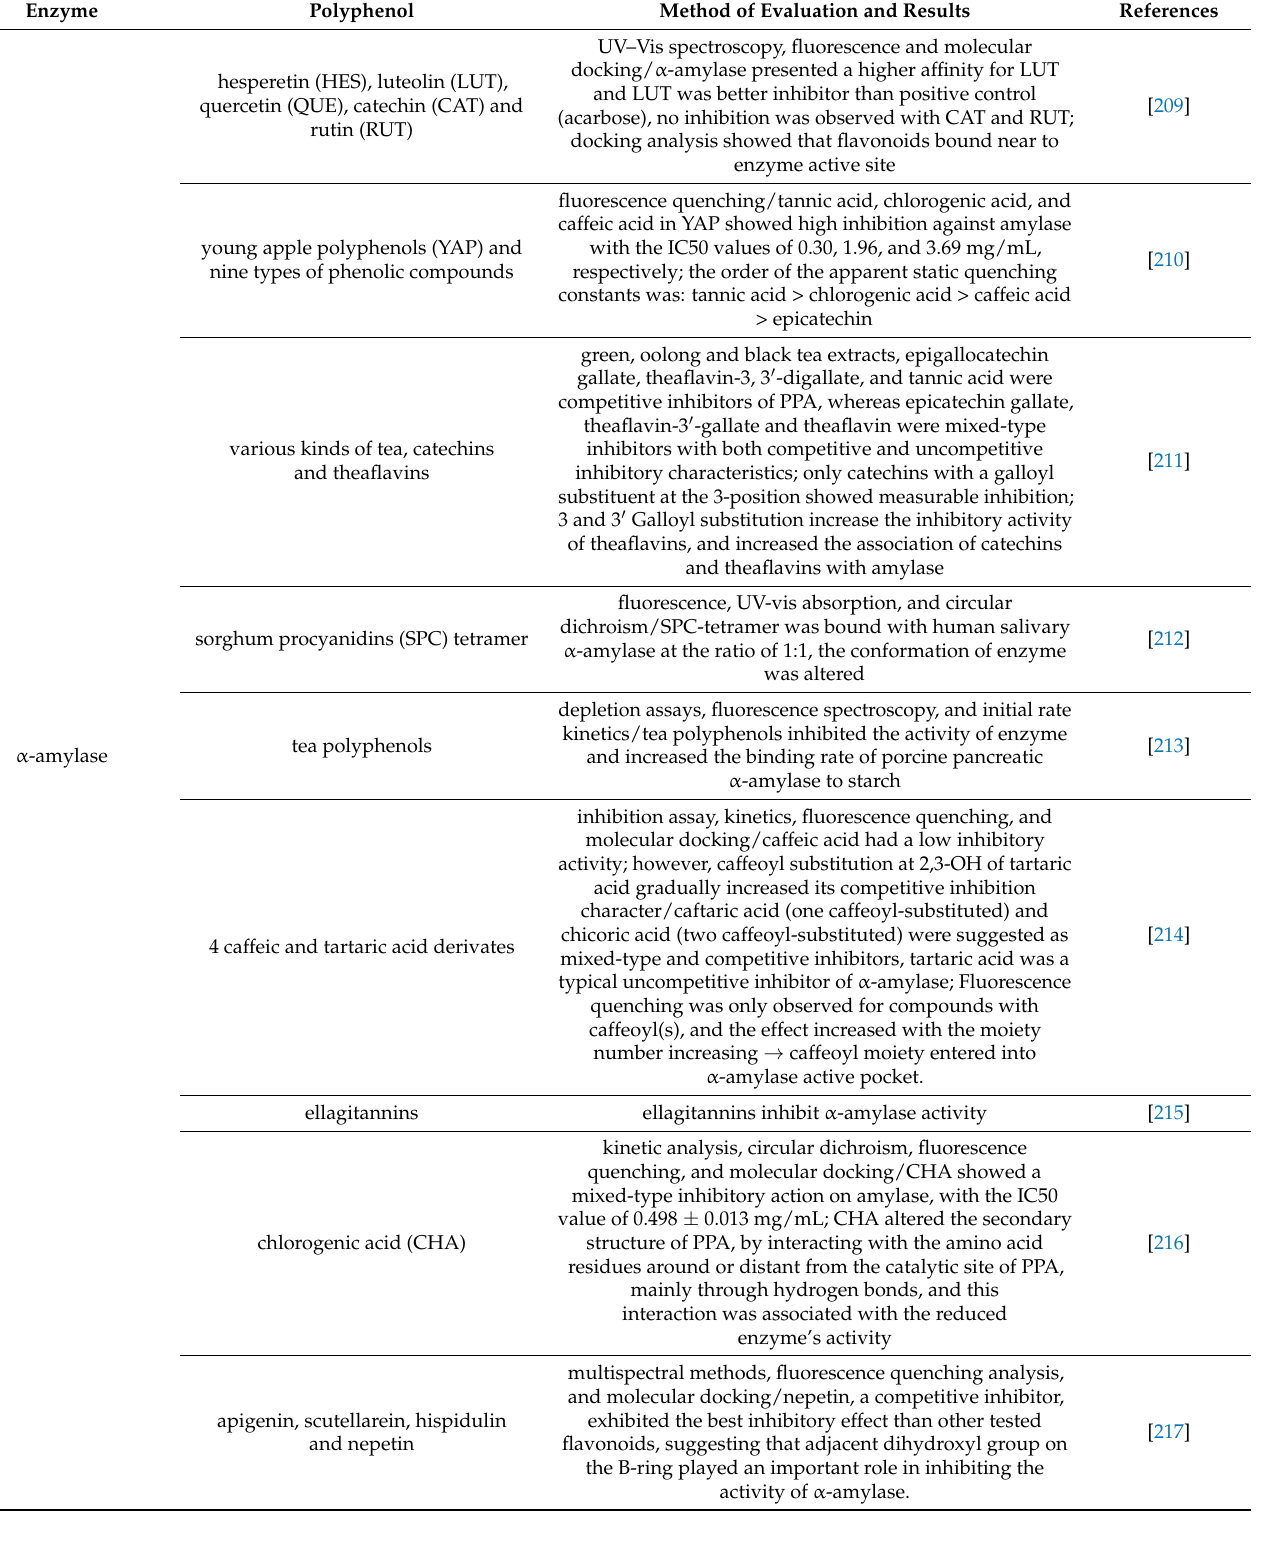
Table 1. Examples of digestive enzymes inhibited by polyphenols (in vitro